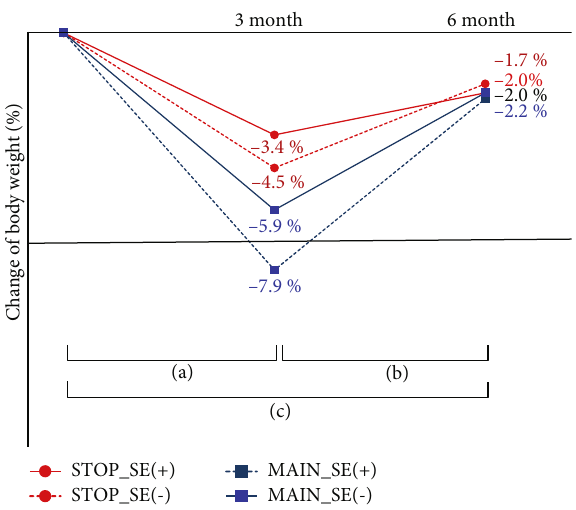
Figure 3: Weight change according to the side e ff ects and discontinuation of liraglutide. (a) p < 0 : 001 at all group; (b) p < 0 : 001 at MAIN_SE(-) and p < 0 : 01 at STOP_SE(+), STOP_SE(-), and MAIN_SE(+) groups; and (c) p < 0 : 001 at all group. At 3 months, p < 0 : 01 between MAIN_SE(-) and STOP_SE(+) and p < 0 : 001 between MAIN_SE(+) and STOP_SE(-) and between MAIN_SE(+) and STOP_SE(+). At 6 months, all groups did not show statistical signi fi cance for each other.